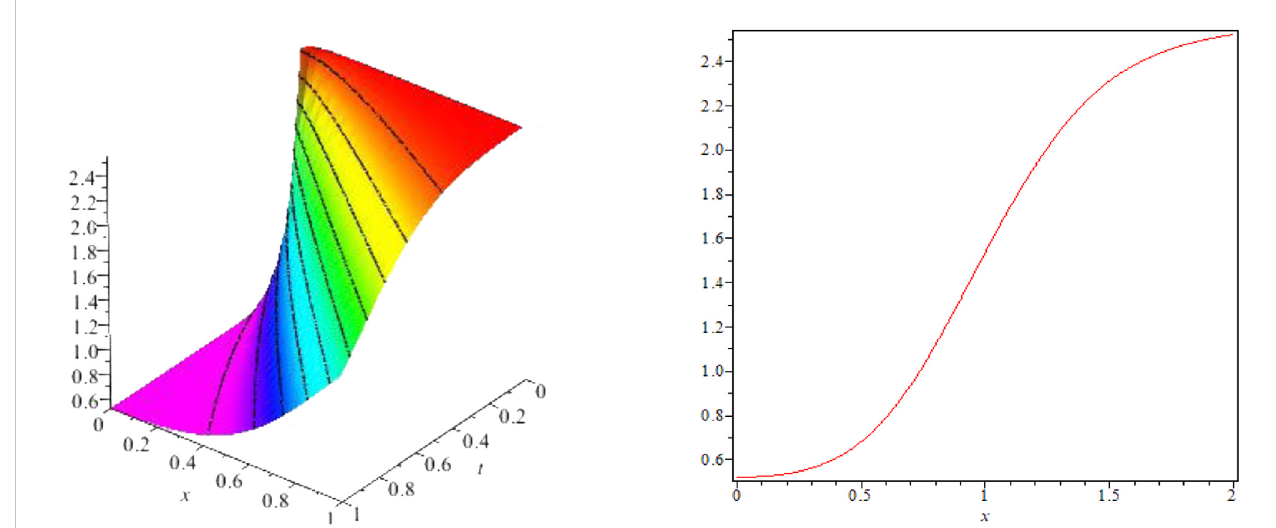
FIGURE 3 Kink-shaped solution for Eq. 35 for Y 7 at ω (cid:2) 1 , k (cid:2) 1 , a 0 (cid:2) 1 , a 1 (cid:2) − 1